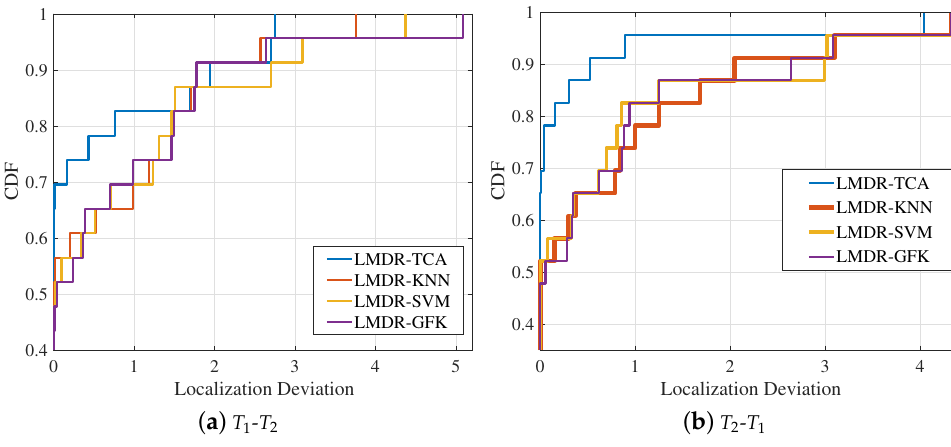
Figure 16. Cumulative distribution function of localization errors in the laboratory.